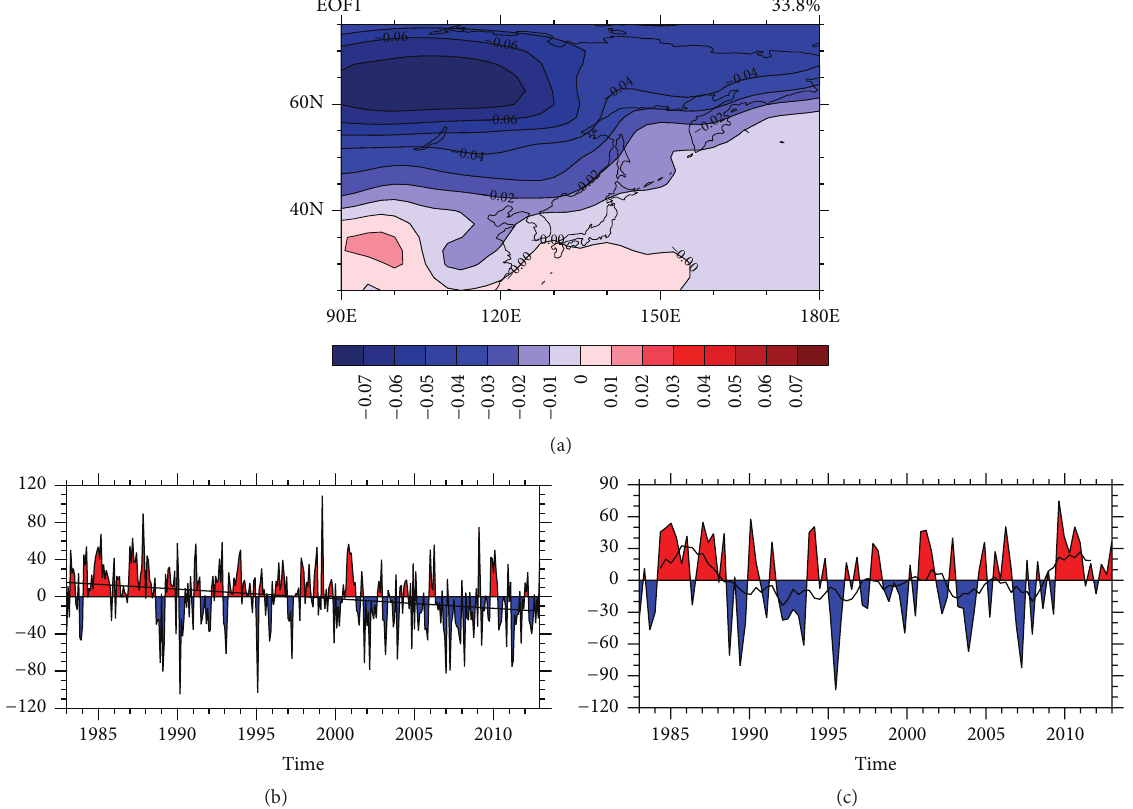
Figure 1: 1983–2012 Asian continent temperature anomaly field at 1000 hPa level: (a) EOF1; (b) PC1: black solid line is linear trend; (c) PC1 in winter time: black solid line is 9-point running mean.